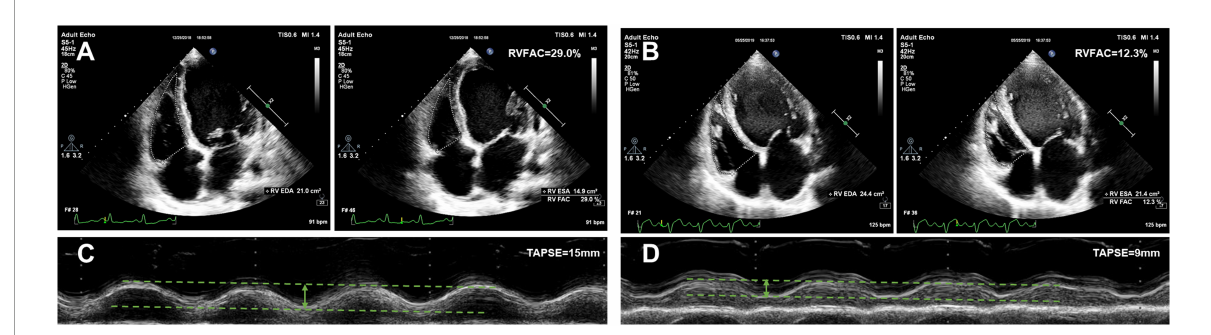
FIGURE2 Representative examples of RVFAC and TAPSE measurement from patients awaiting heart transplant without AKI and with AKI stage 3. (A) RVFAC in the patient without AKI. (B) RVFAC in the patient with AKI stage 3. (C) TAPSE in the patient without AKI. (D) TAPSE in the patient with AKI stage 3. RVFAC, right ventricular fractional area change; TAPSE, tricuspid annular plane systolic excursion.